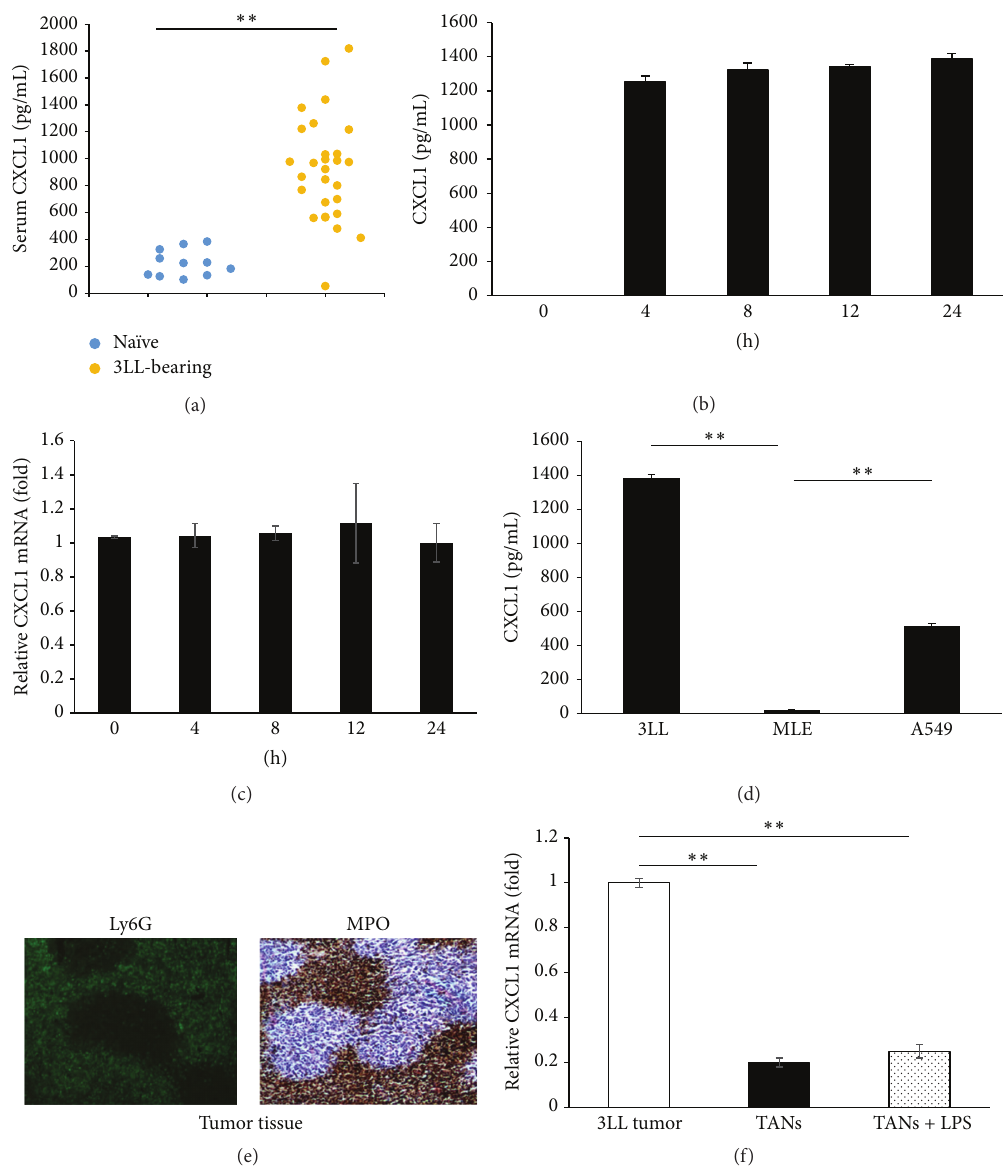
Figure 1: Expression and secretion of CXCL1 in vitro and in vivo . (a) Levels of CXCL1 in the serum of naive mice ( 𝑛 = 11 ) or 3LL tumor- bearing mice ( 𝑛 = 27 ) were measured by ELISA at 14 days after tumor inoculation. Each dot represents an individual mouse. (b) CXCL1 protein levels in the 3LL culture supernatants were determined by ELISA. (c) mRNA expression of CXCL1 in 3LL cells was measured by quantitative RT-PCR. (d) ELISA analysis of CXCL1 production in Lewis lung carcinoma cell line 3LL, mouse epithelial cell line MLE, and human non-small lung carcinoma cell line A549. (e) Ly6G + MPO + neutrophils in 3LL tumor tissues were determined by IF and IHC. (f) Quantitative RT-PCR analysis of CXCL1 expression in 3LL tumor cells and TANs (sorted from 3LL tumor tissues) stimulated with or without LPS (100ng/mL) for 6 hours. ∗∗ 𝑝 < 0.01 ; data are shown as mean ±